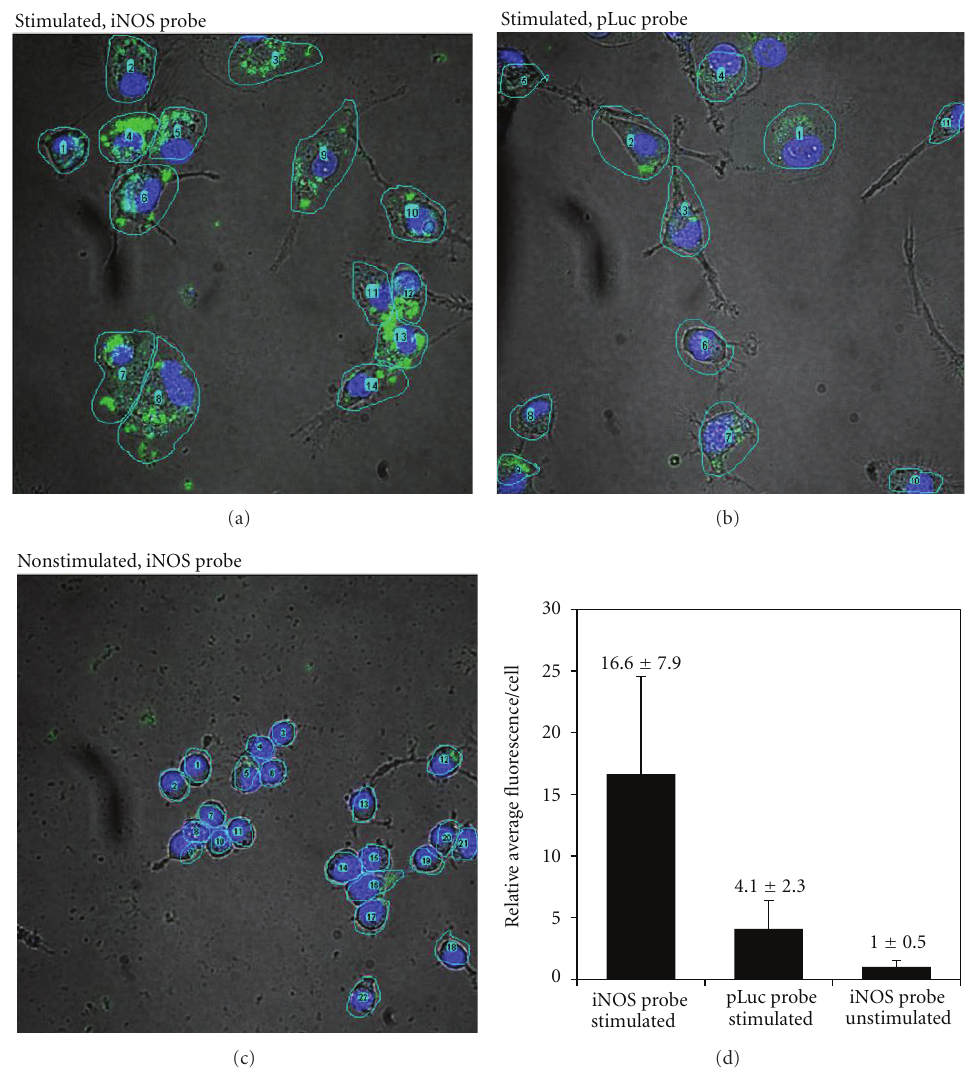
Figure 7: Live cell imaging of iNOS mRNA expression with the strand-displacement probes. Z-stack projection of confocal fluorescent images of RAW 264.7 cells and the quantitative analysis of fluorescence in selected regions of interests (ROIs) 24h after transfection. The iNOS probe (0.4 μ M FAM-iNOS-PNA annealed to 0.5 μ M iNOS-DNA-DABCYL) or pLuc probe (0.4 μ M FAM-pLuc-PNA annealed to 0.5 μ M pLuc-DNA-DABCYL) was delivered with 9.7 μ g/mL cSCK nanoparticle at an N/P ratio of 8 :1. Green: FAM signal. Blue: Hoechst nuclear